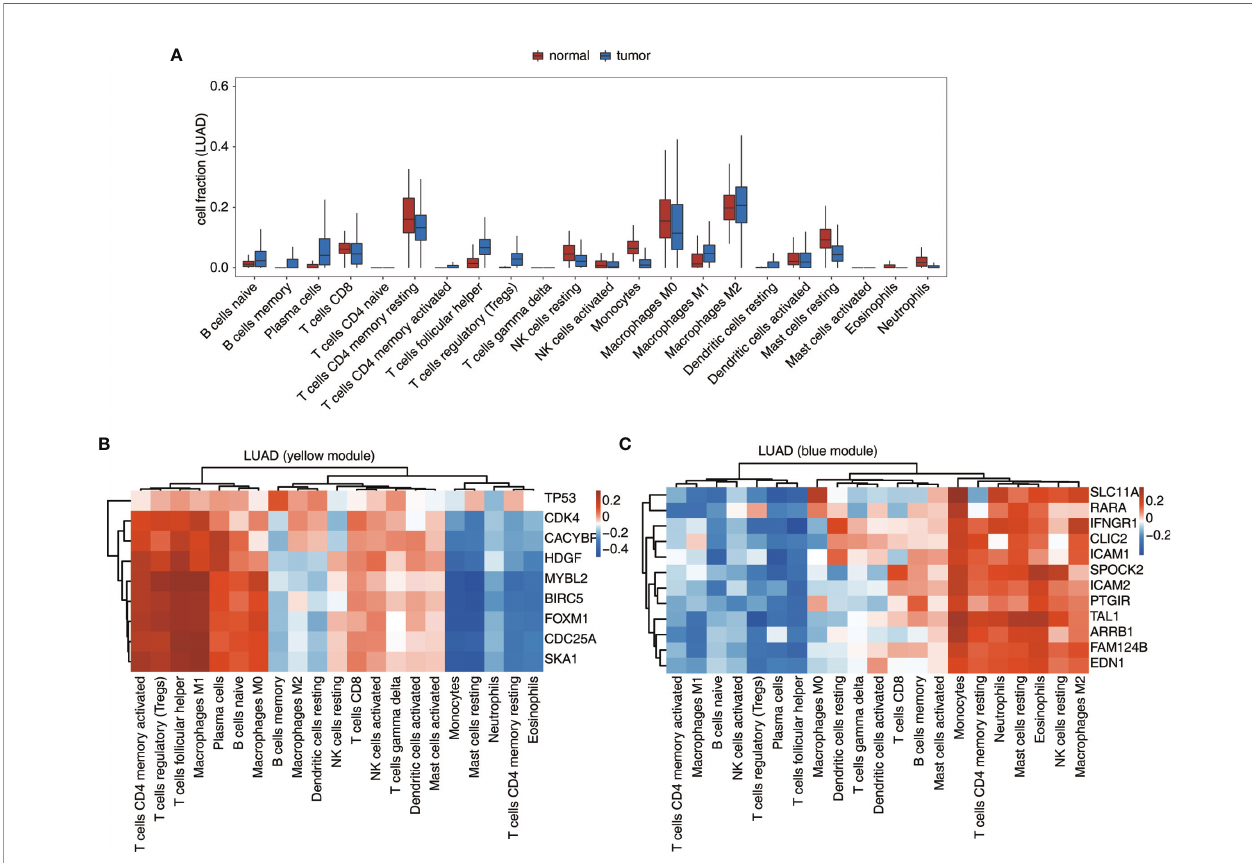
FIGURE 4 | Validation of the TF-iGEN in TCGA datasets. (A) Boxplot showing the fraction of each immune cell type in tumor or normal samples using the LUAD dataset. (B, C) Correlation between immune cell population and the expression of genes from the TF – immune-related gene network in the (B) yellow module and the (C) blue